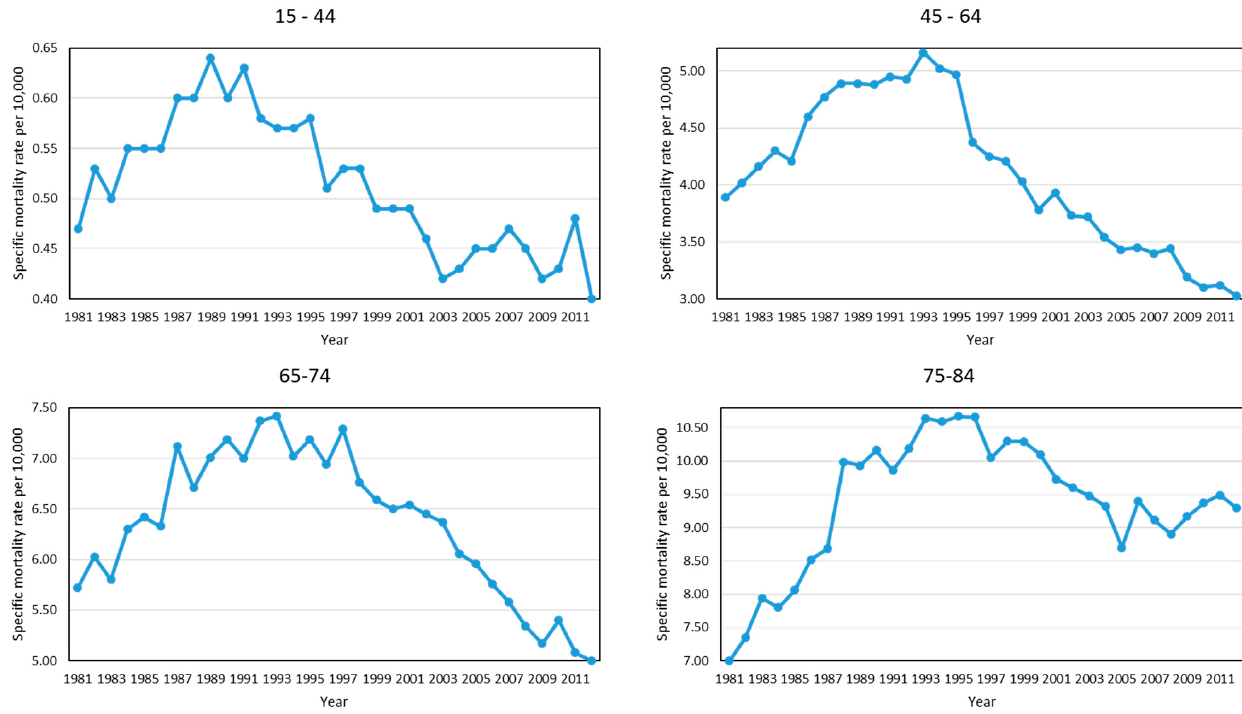
Figure 3. Trend of age-specific mortality rate per 10,000 women with respect to female breast cancer in Spain, 1981–2012.